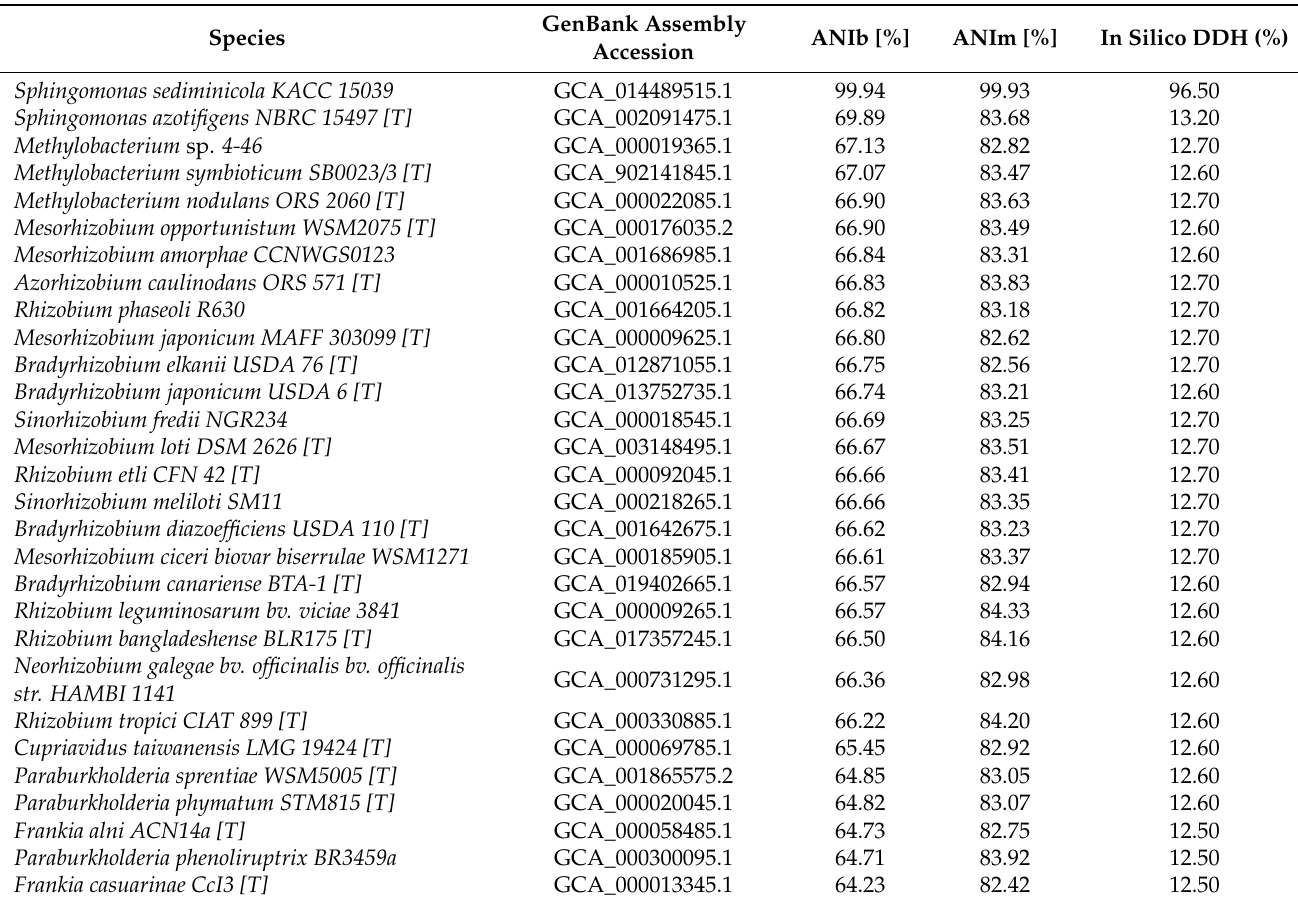
Table 1. Average nucleotide identity (ANI) and in silico DNA–DNA hybridisation (DDH) compar- isons between Sphingomonas sediminicola , S. sediminicola KACC 15039, Sphingomonas azotifigens , and some rhizobia genome